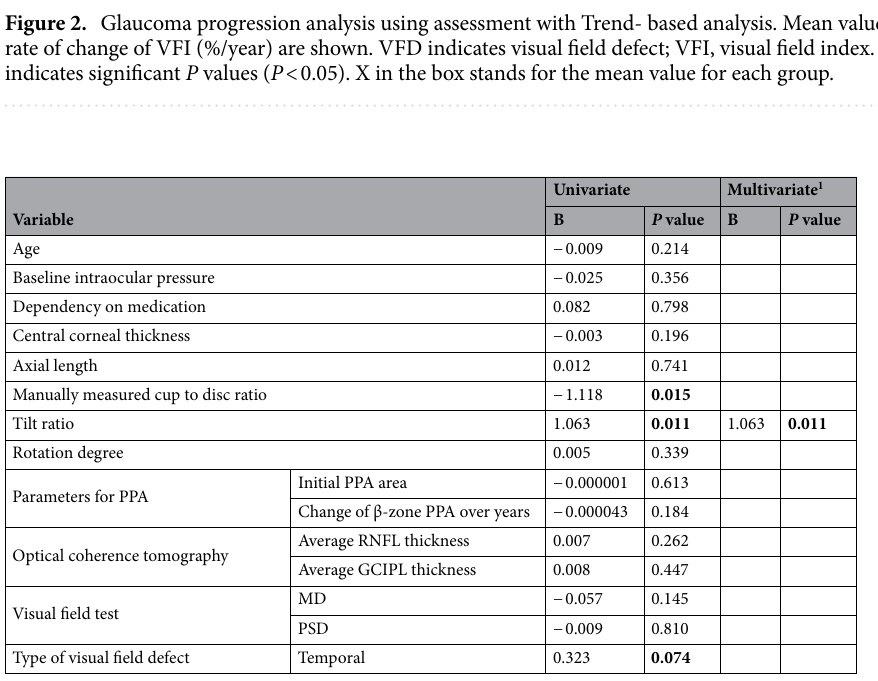
Table 5. Linear regression analysis to Determine the Correlation between Variables and Visual Field defect progression (trend- based GPA) in All eyes (N, 116). GPA guided progression analysis, PPA peripapillary atrophy, RNFL retinal nerve fiber layer, GCIPL ganglion cell inner plexiform layer, MD mean deviation, PSD pattern standard deviation. Average RNFL and GCIPL thicknesses were corrected with the Littmann’s formula. Only variables with a P value < 0.10 in the univariate analysis were included in the multivariate model. (Multivariate 1 Analysis with stepwise or forward method, while Multivariate 2 Analysis with backward method). Bold font indicates significant P values ( P <